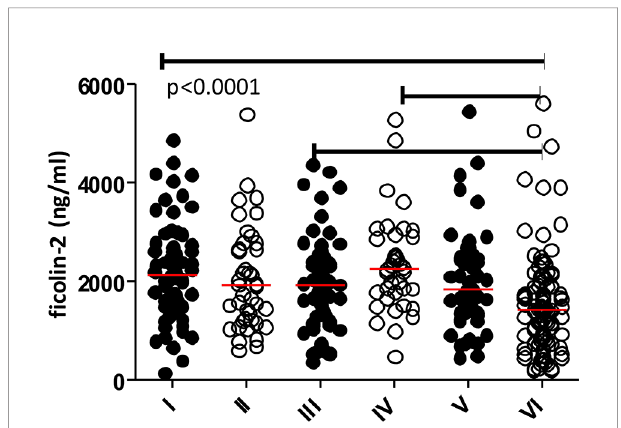
FIGURE 3 | Individual concentrations of fi colin-2 in cord serum samples from preterm neonates in diplotype subgroups. Medians are shown as red bars. Median for the VIth subgroup differs signi fi cantly from those for the Ist, IIIrd and IVth